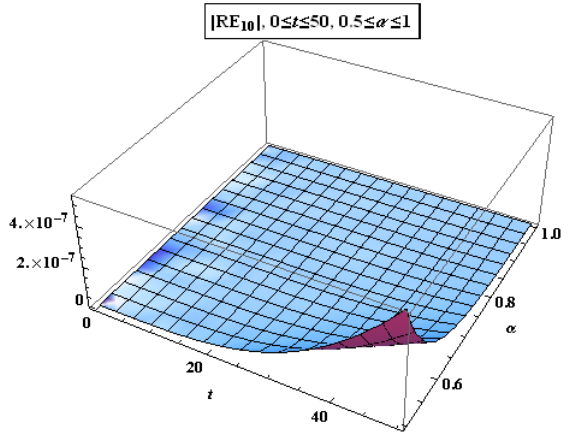
Figure 7. Residual at α = 0.8, q = 2, 0 ≤ λ ≤ 5.